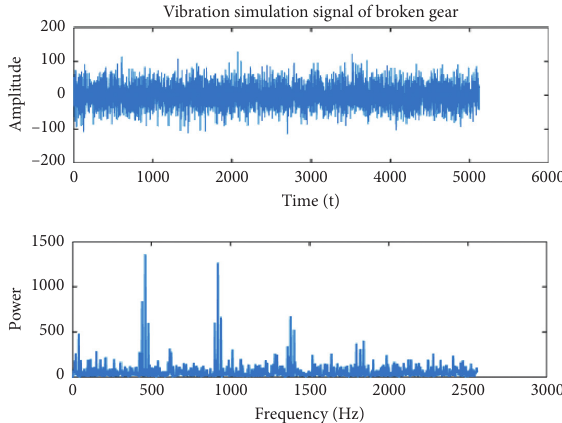
Figure 2: Vibration simulation signal of normal gear.